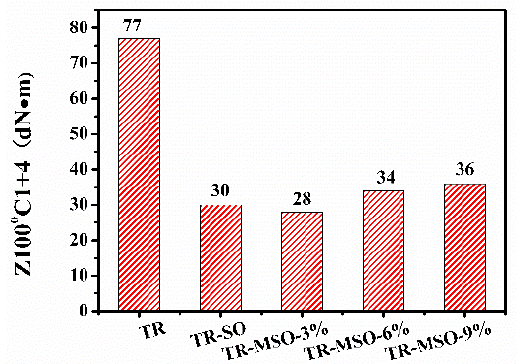
Figure 2. Mooney viscosity of tread rubbers with different plasticizers.